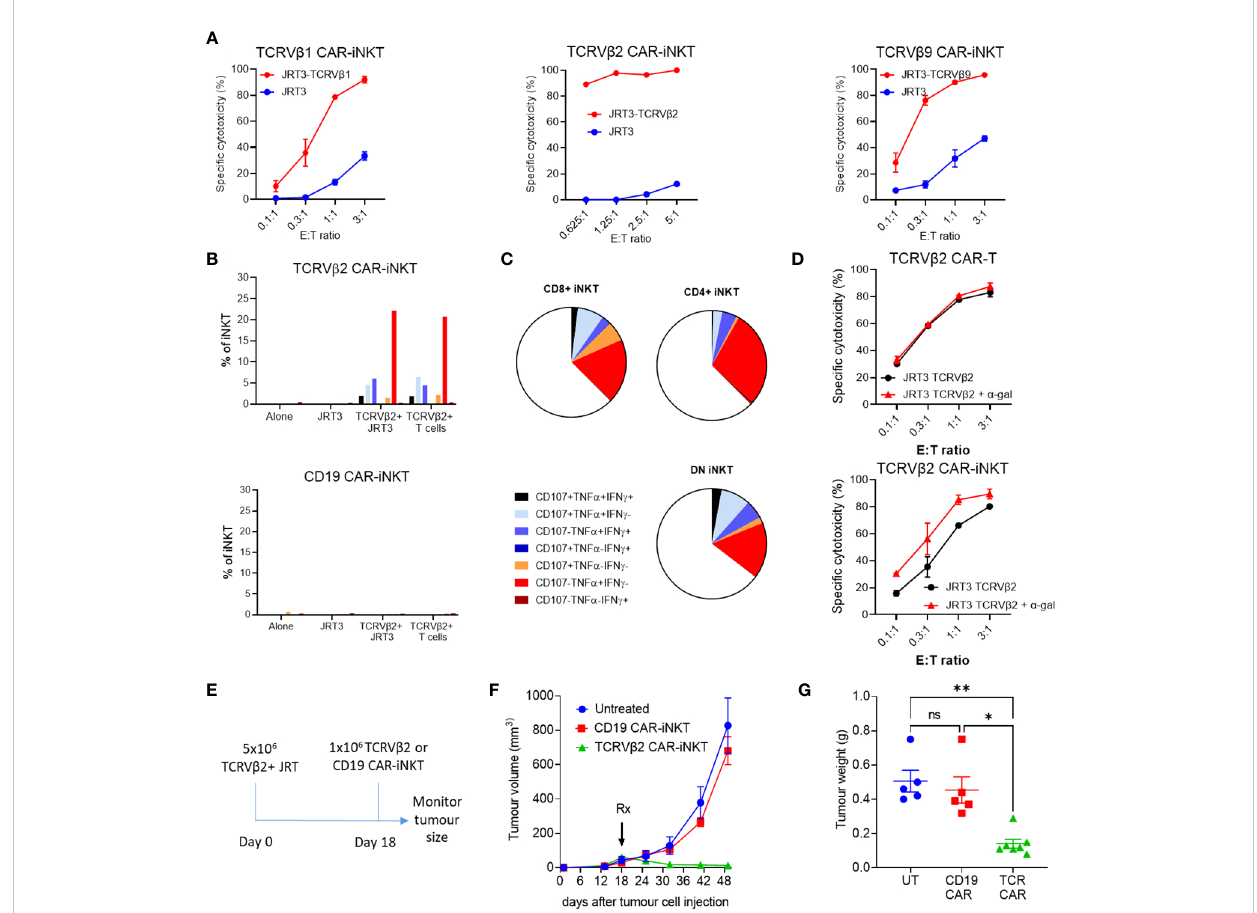
FIGURE 2 Cytotoxic activity of anti-TCRV b CAR-iNKT in vitro and in vivo . (A) Killing of untransduced (JRT3) and TCR-GFP-transduced (JRT3-TCRV b ) JRT-3 T 3.5 cells by anti-V b CAR-iNKT cells. Target cells were stained with CFSE co-cultured with effectors at a range of effector to target (E:T) ratios in duplicate. After 24h cells were harvested and stained with 7aad. The frequency of dead targets in each culture condition was assayed by fl ow cytometry. Results are representative of two or more independent experiments. (B) CD107a mobilisation, IFN- g and TNF- a production by CD3+ anti-V b 2 and anti-CD19 CAR-iNKT when cultured alone or in the presence of untransduced JRT3-T3.5 cells (JRT), JRT3-T3.5 cells transduced with V b 2+ TCR-GFP (V b +), or primary cells expressing V b 2 (TCRV b 2+T cells). Results are from a single experiment and are representative of 2 independent experiments. (C) Representative data showing cytokine production and degranulation by CD4+, CD8+ and double negative CAR-iNKT. (D) Enhancement of killing of a -gal loaded TCRV b 2-GFP-transduced JRT3-T3.5 cells by anti-V b 2 CAR-iNKT but not anti V b 2 CAR-T cells. Where indicated, target cells were incubated with 200ng/ml a -gal before co-culture with effectors. Results shown are representative of two repeat experiments. (E) In vivo protocol. 5x10 6 TCRV b + JRT cells were suspended in Matrigel and injected subcutaneously. On day 18, 1 x 10 6 effector cells were injected intravenously into the tail vein. Groups consisted of untreated (n=5), V b 2 CAR-iNKT (n=7) or CD19 CAR-iNKT (n=5). (F) Tumour volume for each group was measured periodically using calipers and (G) tumour weight was determined after the experiment was terminated. ** indicates p<0.001, * indicates P<0.05 and ns indicates no signi fi cant difference, Kruskal-Wallis test with Dunn's multiple comparisons